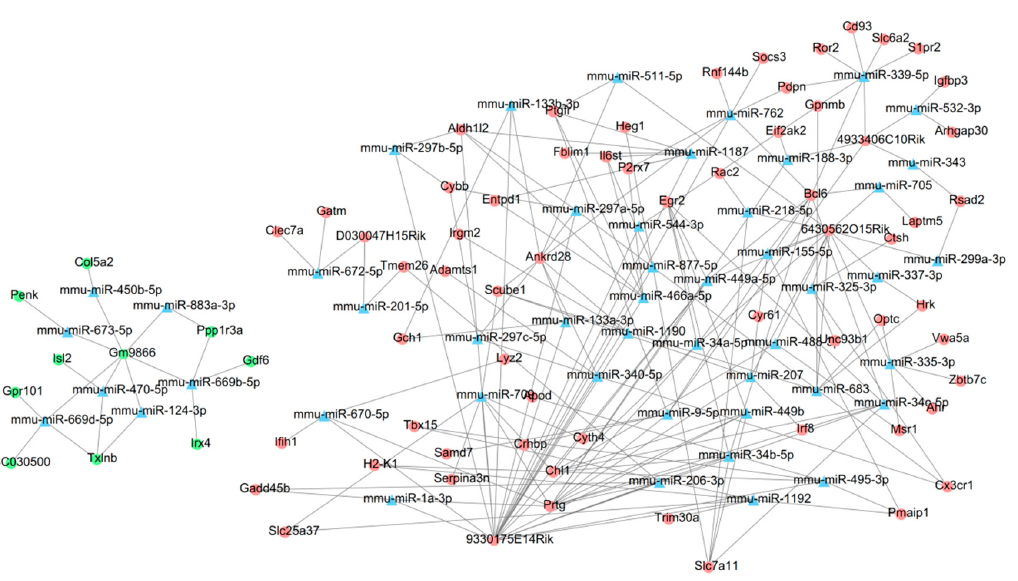
Figure 5. A ceRNA network among differentially expressed mRNAs, lncRNAs and miRNAs. Circle indicates the mRNAs; hexagon indicates the lncRNAs; triangle indicates the miRNAs; Red, upregulated genes; green, downregulated genes; blue, not differentially expressed. ceRNA, competing endogenous RNAs.